Question: Condense the content of this figure into a single sentence.
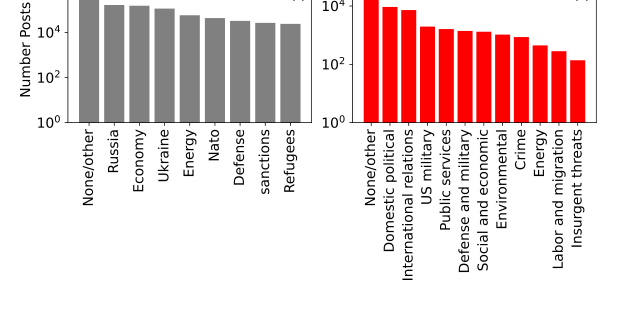
Answer: The frequency of concern posts in coordinated accounts. (a) 2022 French election and (b) 2023 Balikatan U.S.-Philippines military exercises.